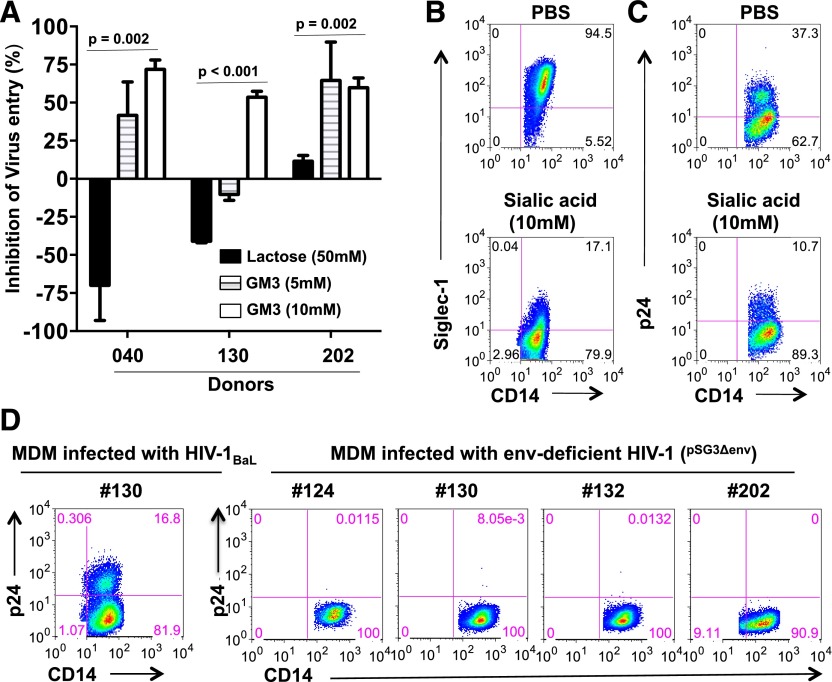
Blocking Siglec-1 receptor with sialyllactose or sialic acid decreases entry and replication of HIV-1.Triplicate wells of M-CSF–derived MDMs were preincubated with PBS (A), lactose, or 2′,3′siallylactose (GM3), or PBS or SA (B and C) for 30 min at room temperature. (A) Cells were washed and infected with US-1 for 30 min, lysed, and the lysates were analyzed for the presence of HIV-1 gag RNA by qRT-PCR. Data are representative of triplicate wells. Bar graph show percentage inhibition of virus entry (means ± sd. (B) MDMs were stained and analyzed for expression of Siglec-1. A representative of 3 independent experiments is shown. (C) The cells were infected with US-1 for 90 min and analyzed on day 4 for the presence of intracellular p24. Data are representative of 2 independent experiments. (D) MDMs were infected with BaL or with envelope (env)-deficient HIV-1 (pSG3Δenv) for 90 min and analyzed on day 4 for the presence of intracellular p24. Panels show dot plots of MDMs infected with BaL or with env-deficient HIV-1 (pSG3Δenv).